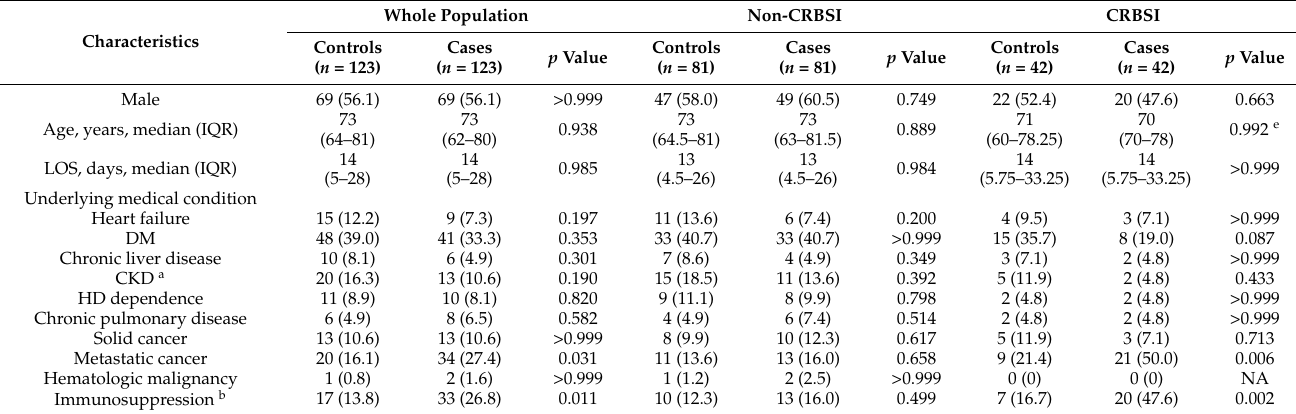
Table 1. Clinical characteristics of patients with candidemia and matched